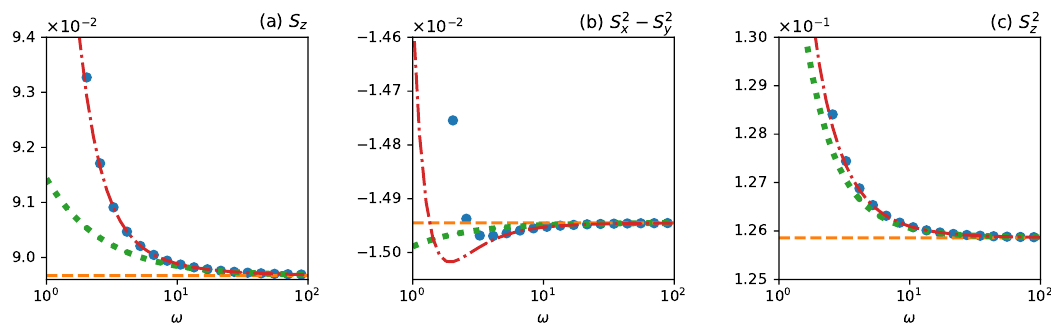
Figure 8: One-cycle averages of observables in the NESS [ Eq. (92) ] plotted against ω . Here ρ ( t ) is calculated by the exact numerical integration (blue) and by the ness HF expansion approach at order N = 0 (orange), 1 (green), and 2 (red). For each = (cid:98) ( N + 1 ) / 2 (cid:99) . The parameters N , we expand H and K ( t ) up to O ( ω − N ) and set k c eff are the same as in Fig. 7 except ω .